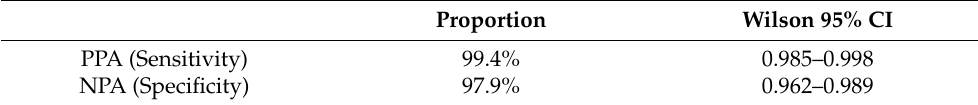
Table 4. Sensitivity and specificity of EliA SARS-CoV-2-Sp1 IgG (Phadia S1 IgG) at 0.7 EliA U/mL cut-off and 97.9% specificity in an internal